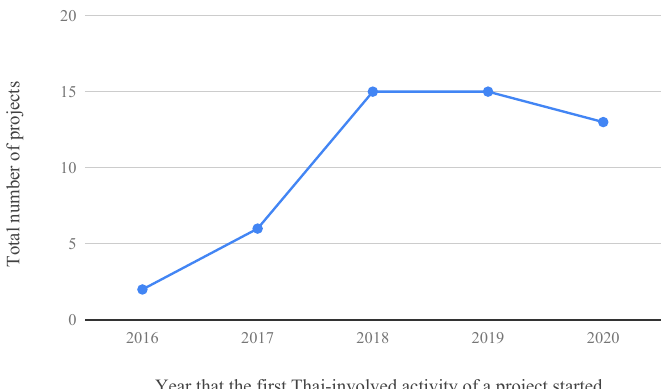
Figure 12. A trend of blockchain projects publicly known in Thailand.